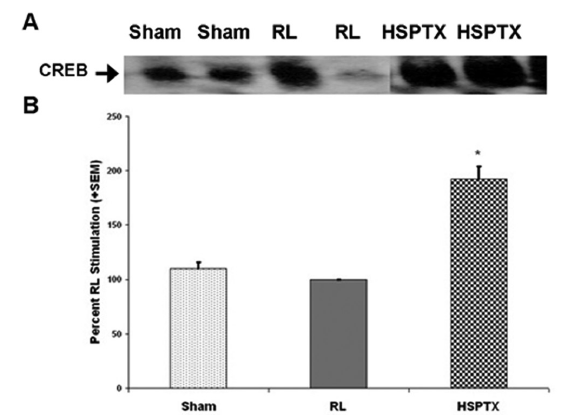
Figure 5 - CREB-DNA Binding Activity After Hemorrhagic Shock and Resuscitation. A, Representative EMSA illustrating CREB DNA-binding activity at 4 hours after post-shock resuscitation. The image displays two rep- resentative animals from each experimental group. B, Histogram presenting changes in mean pixel density for n = 5-7 animals per group compared with RL-treated animals. Enhanced CREB-DNA binding activity was observed in animals receiving HSPTX infusion. RL-treated animals had CREB-DNA association levels similar to the sham group. *, p = 0.001 vs. RL.